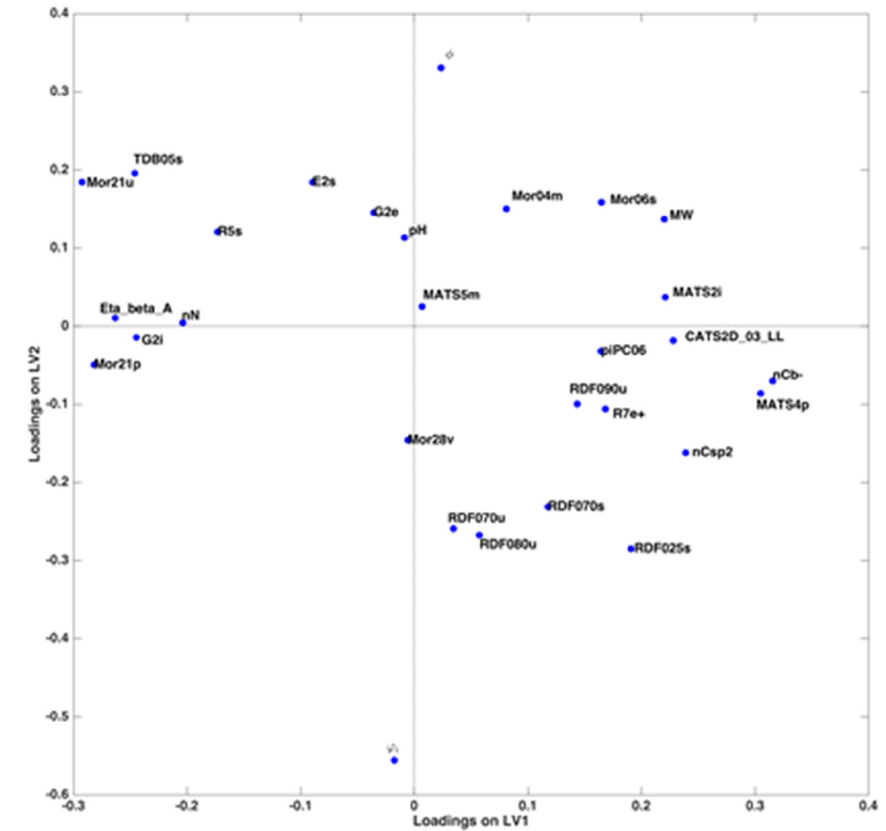
Figure 3. Variables loadings projected on the first two latent variables of the PLS model.